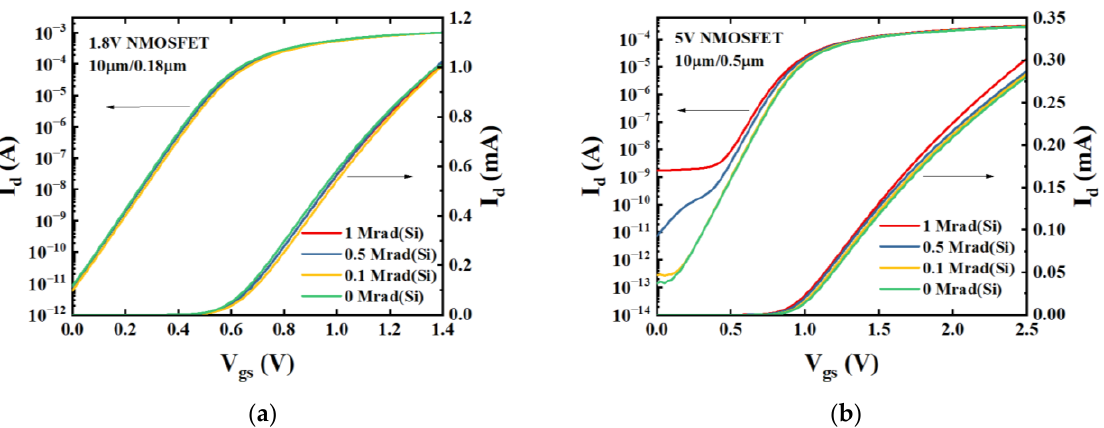
Figure 3. I d – V gs curves in the linear region ( V ds = 0.1 V) of ( a ) 1.8V NMOSFETs for geometry: W / L = 10 μm/0.18 μm and ( b ) 5 V NMOSFETs for geometry: W / L = 10 μm/0.5 μm. All devices were irradiated up to 1 Mrad(Si) under the “on” bias condition.